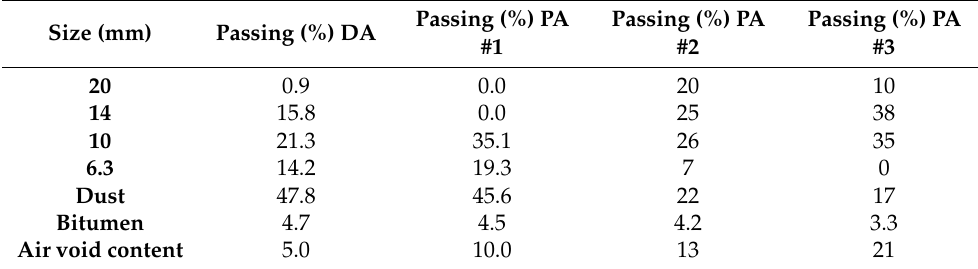
Table 2. Asphalt mixture